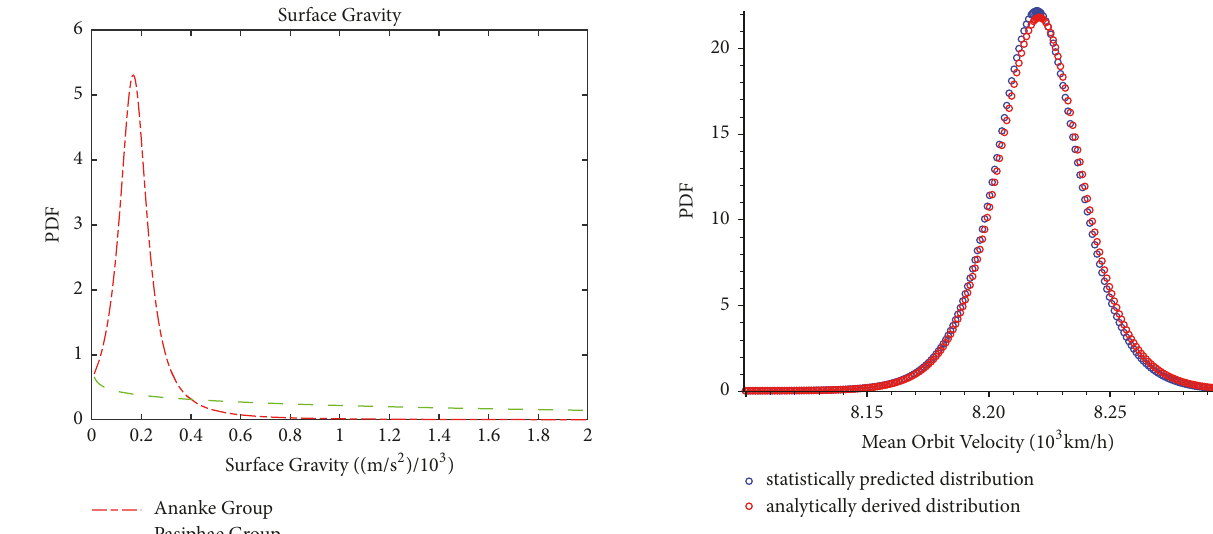
Figure 9: Comparison of statistical prediction distribution and analytical derivation